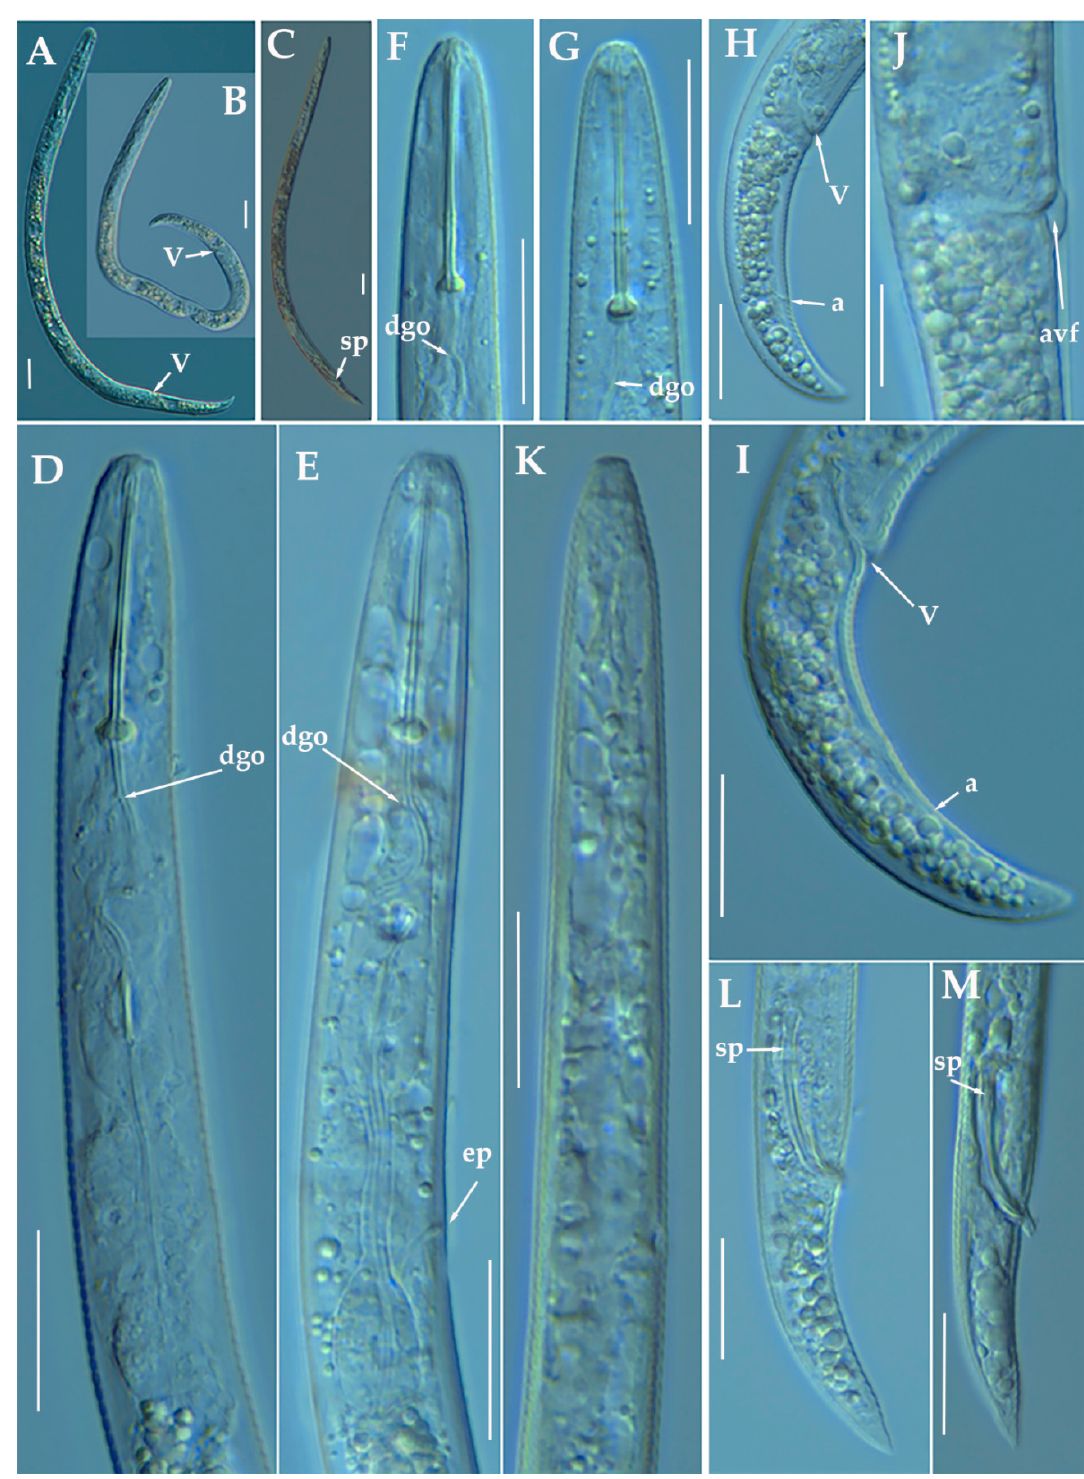
Figure 2. Light photomicrographs of Paratylenchus caravaquenus sp. nov. ( A , B ): Entire female with vulva arrowed; ( C ): Entire male with spicules arrowed; ( D , E ): Female pharyngeal region; ( F , G ): Female lip region; ( H , I ): Female posterior region with vulva and anus (arrowed); ( J ): Detail of vulva showing advulval flap (arrowed); ( K ): Male pharyngeal region showing absence of stylet; ( L , M ): Male posterior region showing spicules (arrowed). Scale bars ( A – I , K – M = 20 µ m; J = 10 µ m). (Abbreviations: a = anus; avf = advulval flap; dgo = pharyngeal dorsal gland orifice; ep = excretory pore; sp = spicules; V = vulva).